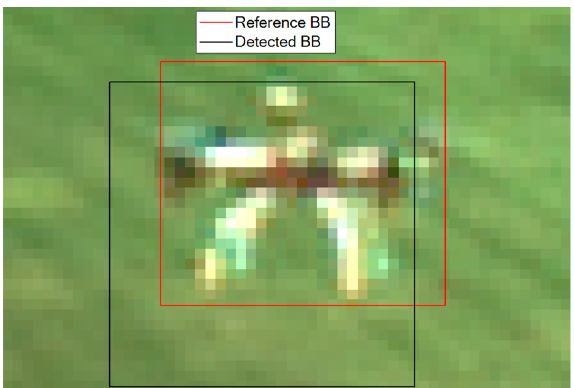
Figure 5. Example of best YOLO detection. IoU =0.538. The reference BB, obtained using a supervised approach, is approximately centered at the geometric center of the target. The detected BB is the output of the DL-based detector.